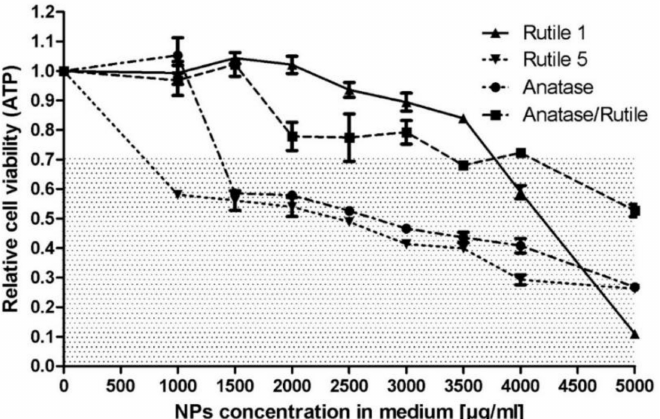
Figure 8. Cytotoxicity of TiO 2 particles after 24 h of exposure to NIH/3T3 mouse embryonic fibroblast cells. The patterned area shows concentrations with cytotoxic effects, as defined by EN ISO 10993-5, where a viability > 0.7 corresponds to an absence of